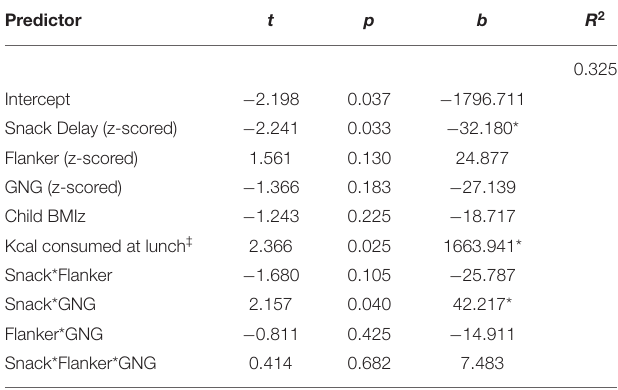
TABLE 4 | Results of the multiple regression analyses examining interactions between self-regulation domains.